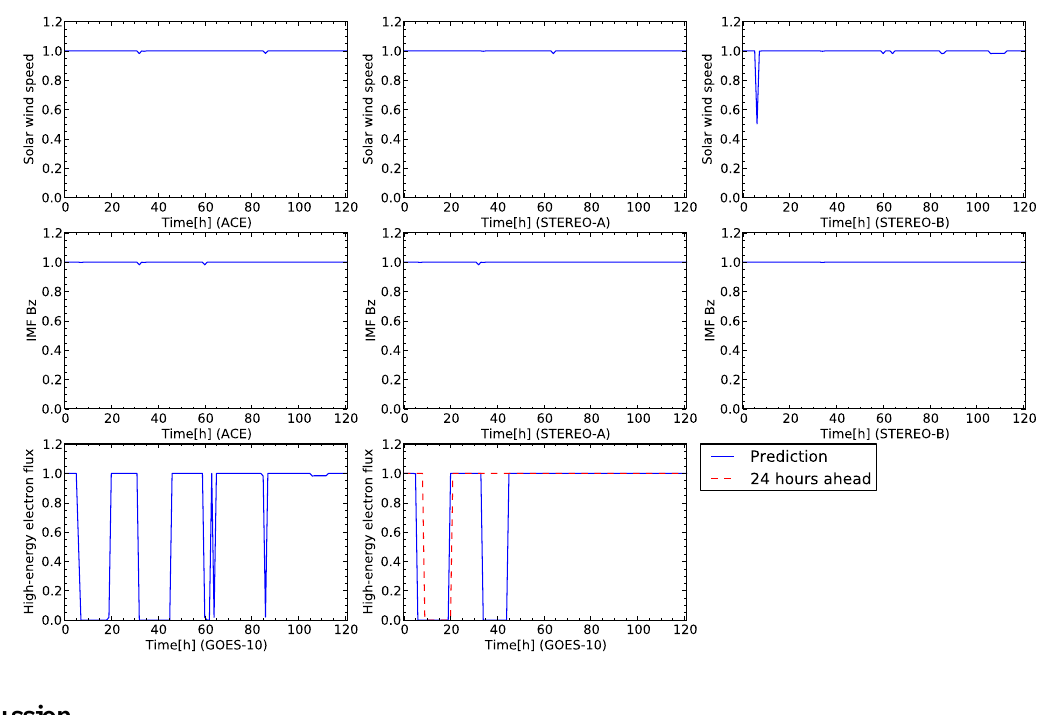
Figure 11. Time development of sensor data for five days from 30 April 2008 at 00:00:00 UTC. This plot contains an event of high-speed solar wind flowing from a coronal hole. In the first and second rows, the plots of the columns correspond to the satellites of ACE, STEREO-A, and STEREO-B, respectively. In the third row, the plot corresponds to